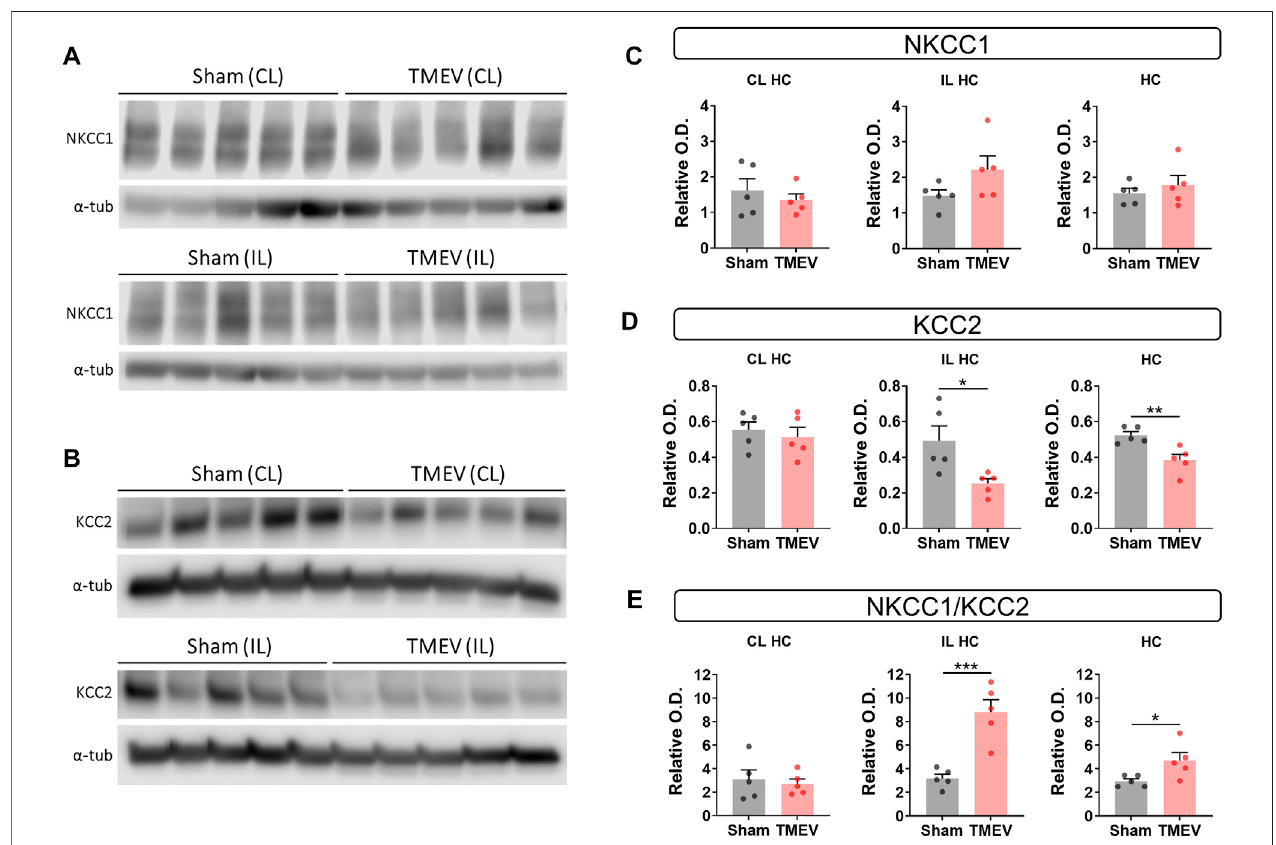
FIGURE3| DecreaseintheproteinlevelofKCC2andincreaseintheratioofNKCC1/KCC2inthehippocampusofTMEV-infectedmicewithacuteseizuresat5dpi. (A – B) Immunoblots show the detection of NKCC1 (A) , KCC2 (B) and α -tubulin in the contralateral (CL) and ipsilateral (IL) hippocampi (HC) from the sham- and TMEV- infected mice. (C – E) Optical density (O.D.) of NKCC1 (C) and KCC2 (D) blots were normalized to the O.D. of α -tubulin blots from the same samples to compare the relative O.D. between the sham- and TMEV-infected mice. The relative O.D. ratios of NKCC1/KCC2 are plotted in panel (E) . Statistics: Unpaired two-tailed t